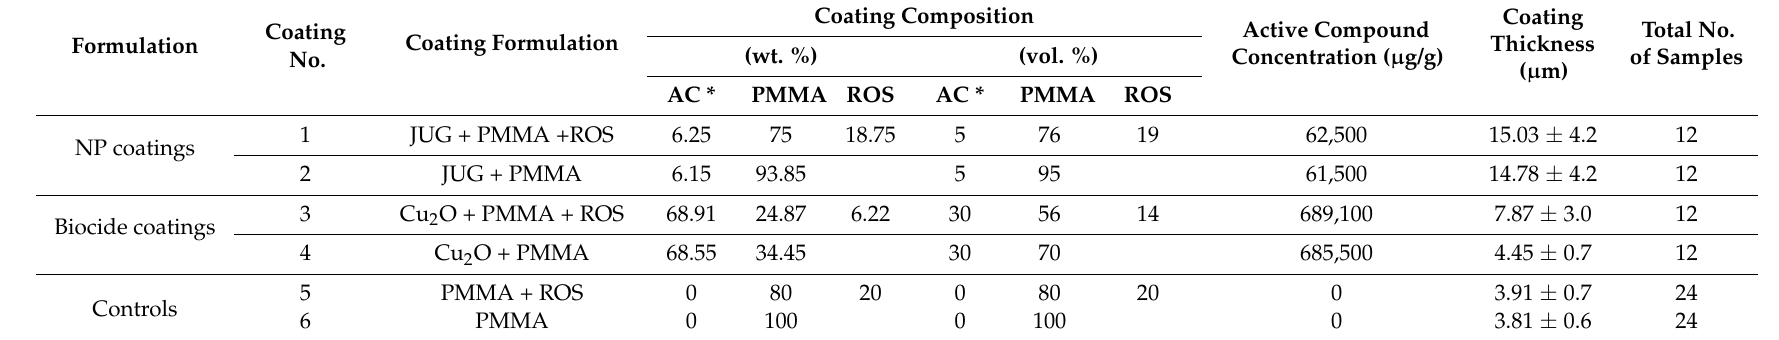
Table 3. Paint formulations used on glass